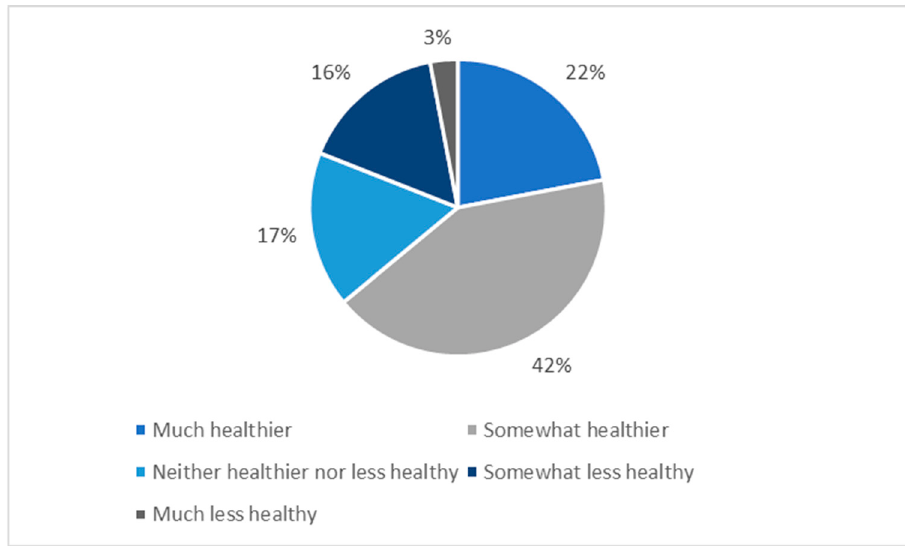
Figure 9 . Perceived impact of COVID-19-related dietary changes on dietary healthfulness. Figure 9. Perceived impact of COVID-19-related dietary changes on dietary